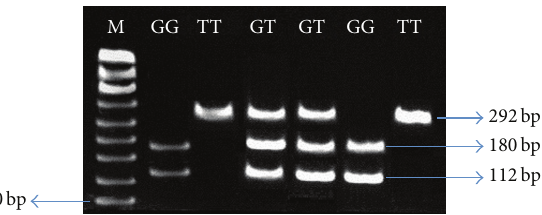
Figure 1: Detection of Ala589Ser polymorphism of WNK4 gene by PCR-RFLP utilizing 2.0% agarose gel electrophoresis. PCR products were digested by AlwNI. Wild type was cut (into 180 and 112bp), while variant type remained uncut. Homozygous genotypes are indicated as GG genotypes, heterozygous genotypes are determined as GT genotypes, and TT genotypes show mutant genotypes. M represented a 50bp DNA ladder plus